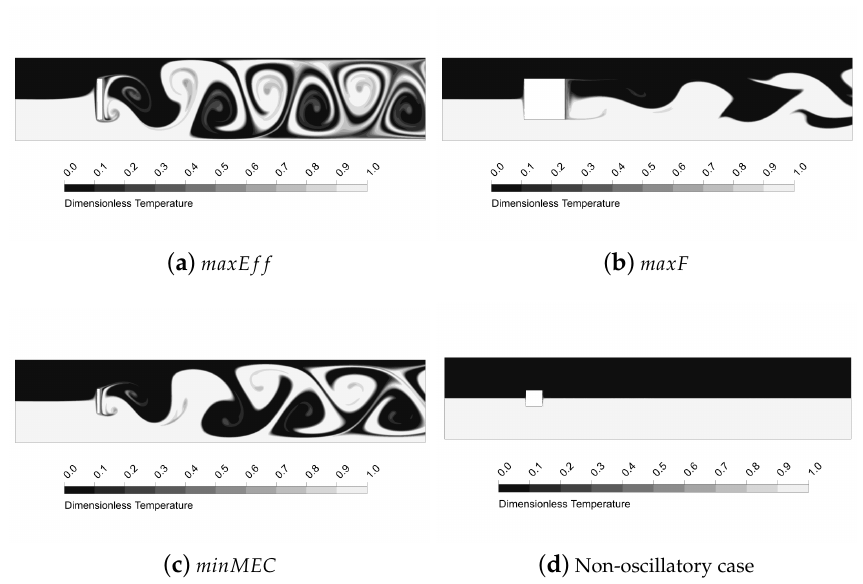
Figure 9. Thermal mixing performance for the micro heat exchangers maxEf f , maxF , minMEC and a non-oscillatory case ( AR = 1, BR = 0.2 and Re =